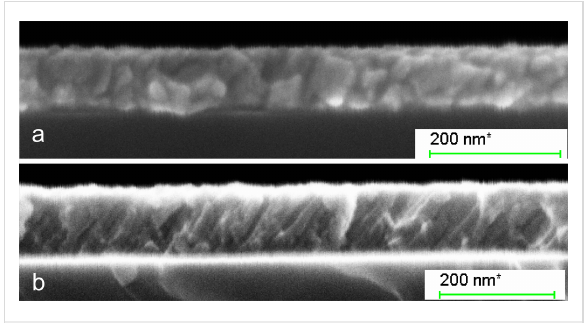
Figure 4: Cross-sectional SEM image of nickel films that were deposited by (a) HiPIMS, and (b) dcMS at 70° substrate tilt angle, at 0.6 Pa, and 150 W